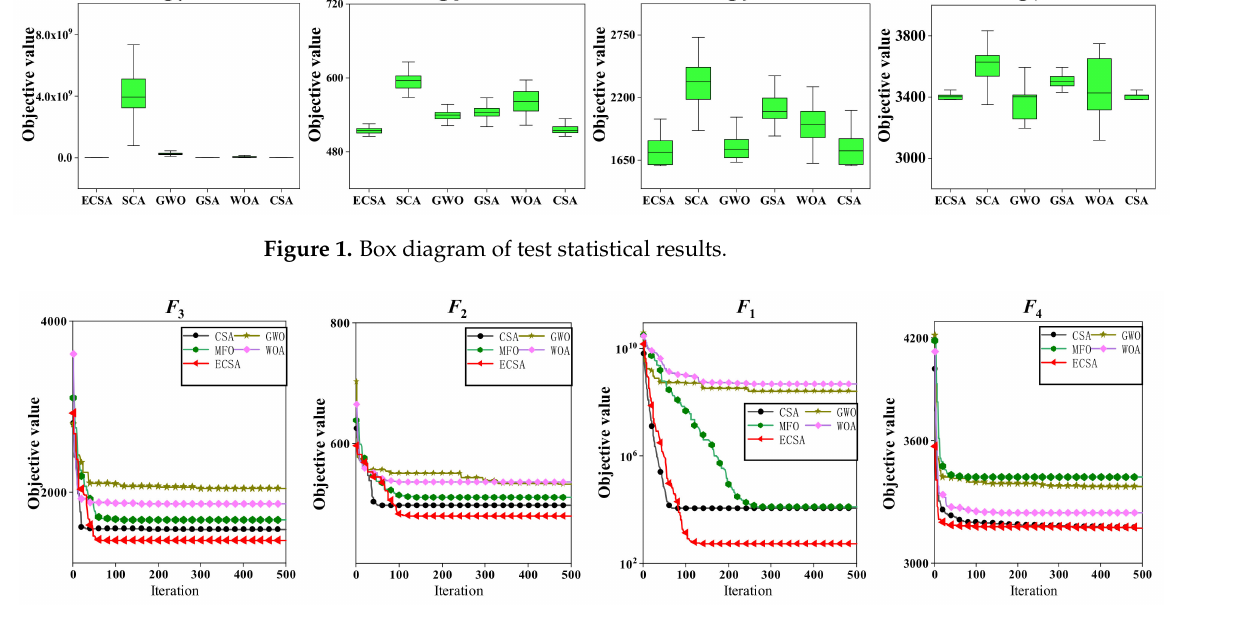
Figure 2. Test function convergence